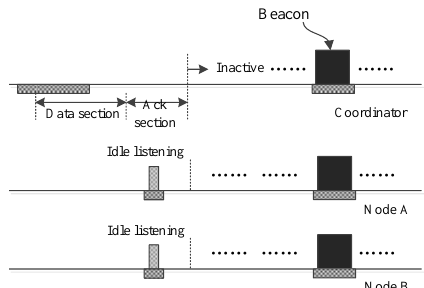
Figure 2. No traffic occurs during two adjacent interposition slots.